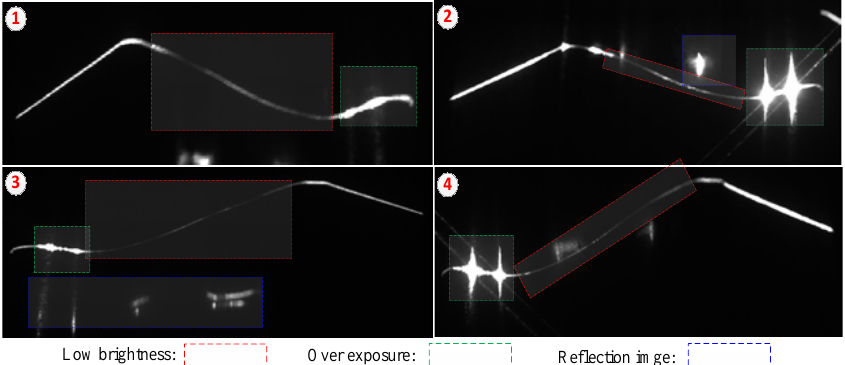
Figure 6. Online stripe images captured from the outer camera. ① and ③ present the stipe images captured with low exposure. ② and ④ exhibit the stipe images captured with high exposure.